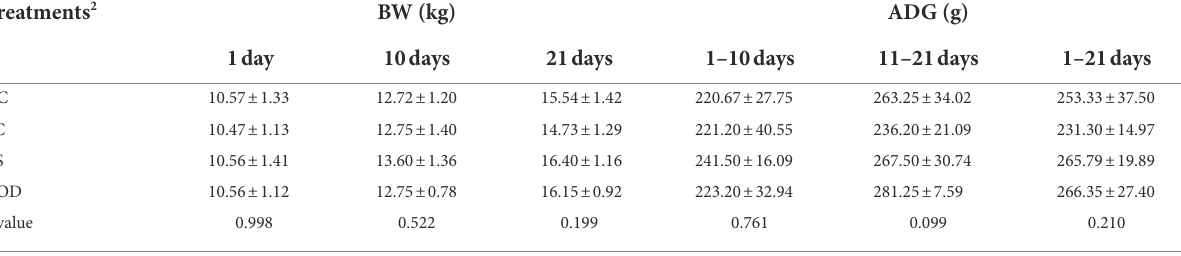
TABLE 2 Effect of dietary treatments on growth performance 1 in piglets challenged by enterotoxigenic Escherichia coli (ETEC). Treatments 2